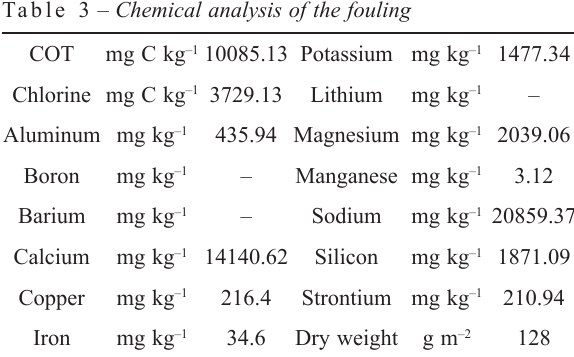
Table 3 – Chemical analysis of the fouling